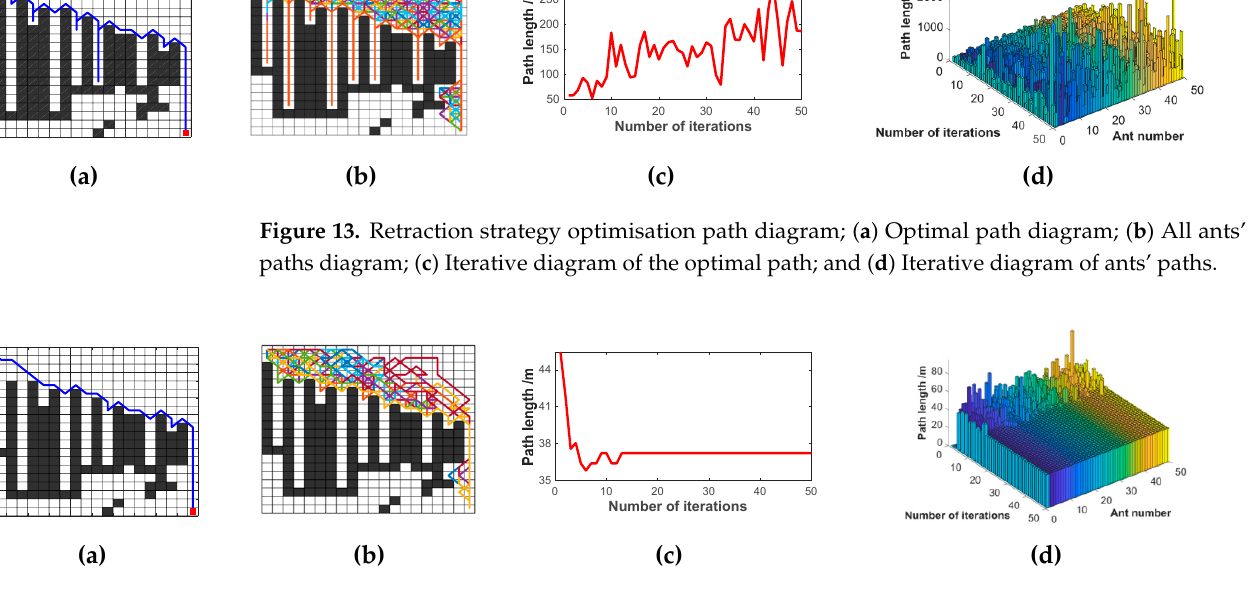
Figure 14. Death Strategy Optimisation Path Diagram; ( a ) Optimal path diagram; ( b ) All ants’ paths diagram; ( c ) Iterative diagram of the optimal path; and ( d ) Iterative diagram of ants’ paths.